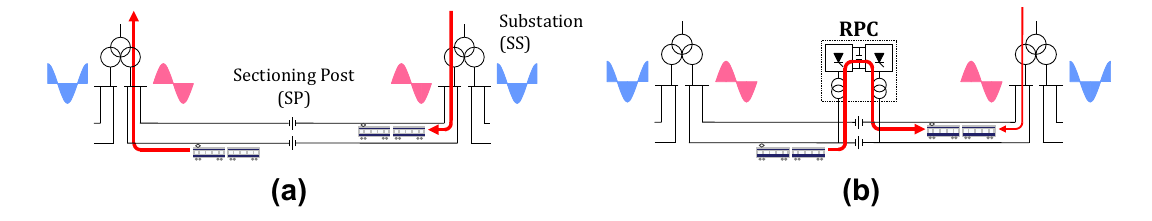
Fig. 14 Regenerative power flow without and with RPC at SP. a Without RPC, b with RPC